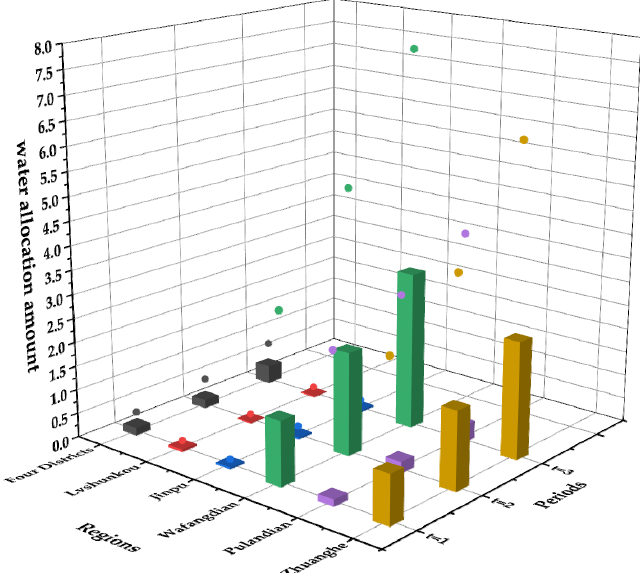
Figure 5. Reused water resource allocations for municipal use (10 4 m 3 /year).